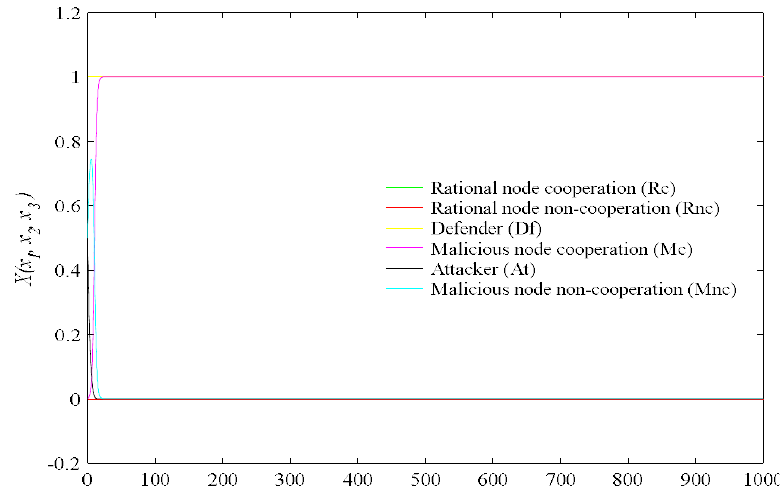
are shown in Figure 8.